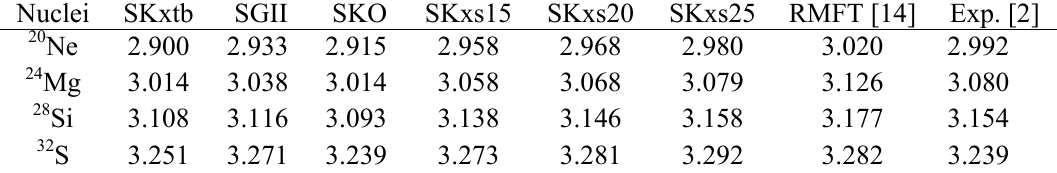
Table 2: Calculated charge rms radii compared with RMFT and experimental results.